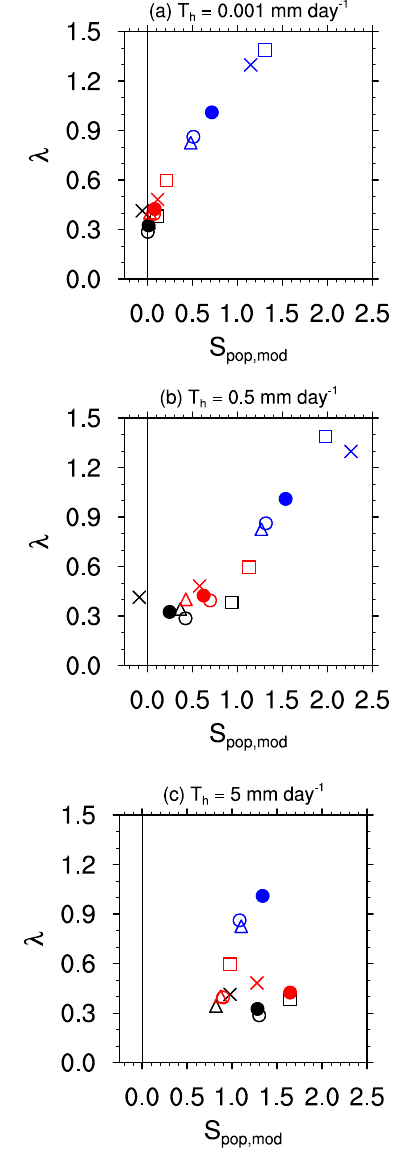
Figure 3. Scatterplot of λ (and A f , right axis) vs. S pop for thresholds T h of (a) 0.001, (b) 0.5, and (c) 5mmday − 1 . These thresholds are representative of the set of 10 thresholds analyzed. Here, the follow- ing colors denote changes in N a from 25mg − 1 to 50mg − 1 (black), 75mg − 1 (red), and 100mg − 1 (blue) for the DYCOMS-II case. The symbols signify the control (solid circles), Hi-LHF (open circles), Lo-LHF (crosses), Lo-CC (open squares), and Hi-CC (open trian- gles) simulations. Note that not all symbols appear, especially for larger changes in N a and high threshold values, because for those conditions, no points meet the criterion for calculating λ and/or S pop . The thin dashed line shows the linear relationship determined by Wang et al. (2012) for the λ – S pop relationship, while the verti- cal dashed line in (b) corresponds to the satellite-measured value of S pop , i.e., 0.12 (Wang et al., 2012), at a similar T h .